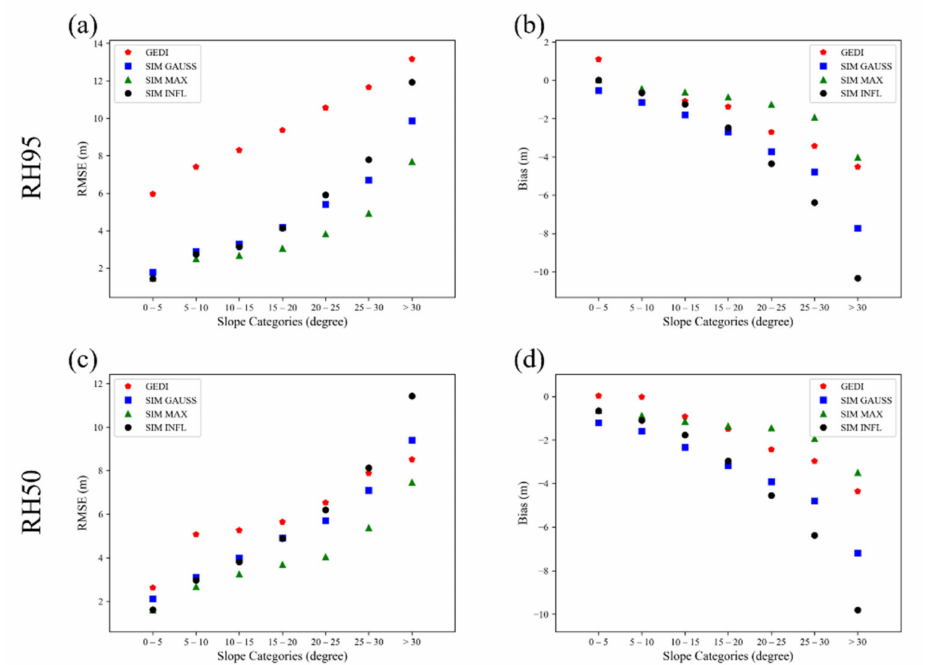
Figure 6. Impact of the terrain slope on RMSE ( a , c ) and bias ( b , d ) for real GEDI observations (red) and simulated GEDI observations of RH95 ( a , b ) and RH50 ( c , d ) using the Gaussian (blue), Maximum (green) and Inflection algorithm